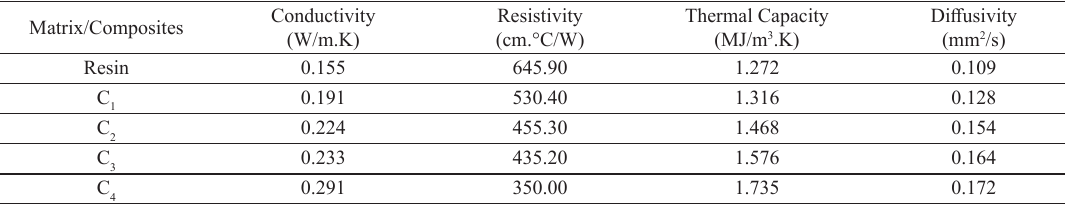
Table 6. Results of thermal analysis for the composites and the polyester resin. Matrix/Composites